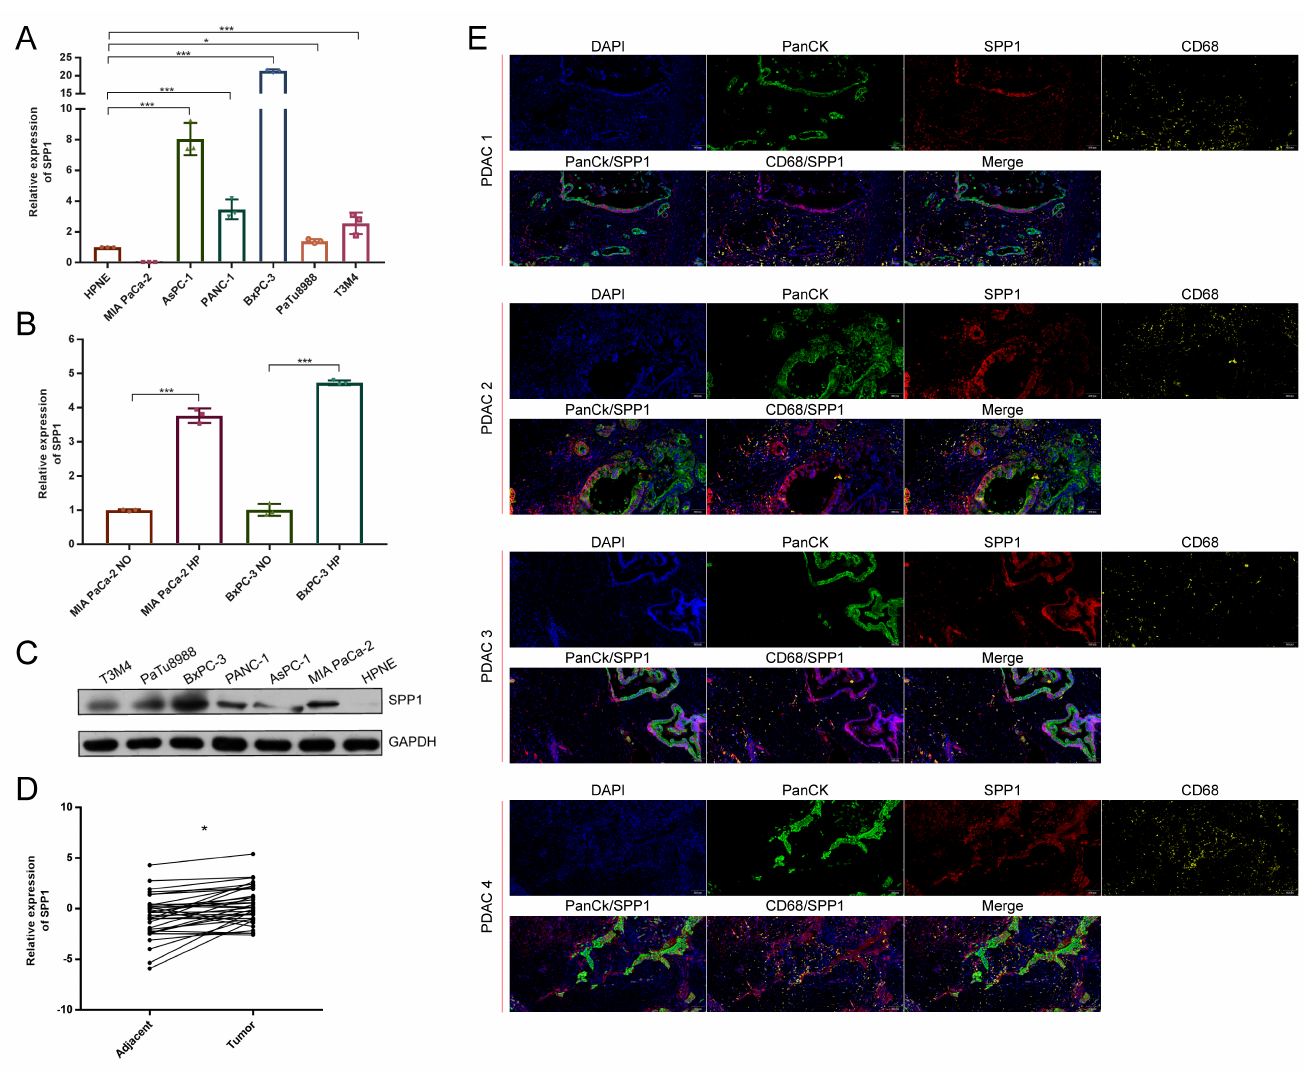
Figure 6. SPP1 was mainly expressed in ductal and macrophage subpopulations of PDAC. ( A ) RT-qPCR was performed to show the expression levels of SPP1 in pancreatic cell lines, and HPNE is a normal pancreatic ductal cell line; ( B ) the expression levels of SPP1 under hypoxic and normoxic conditions; ( C ) western blot showing the expression levels of SPP1 among pancreatic cell lines; ( D ) RT-qPCR showing the relative expression of SPP1 between the tumor and adjacent pancreatic tissues; ( E ) multiple color IHC showing the distribution of SPP1 in PDAC. The SPP1, CD68, and PanCK were labeled with different colors. ND, normoxic; HP, hypoxic. *, *** represent p < 0.05 and